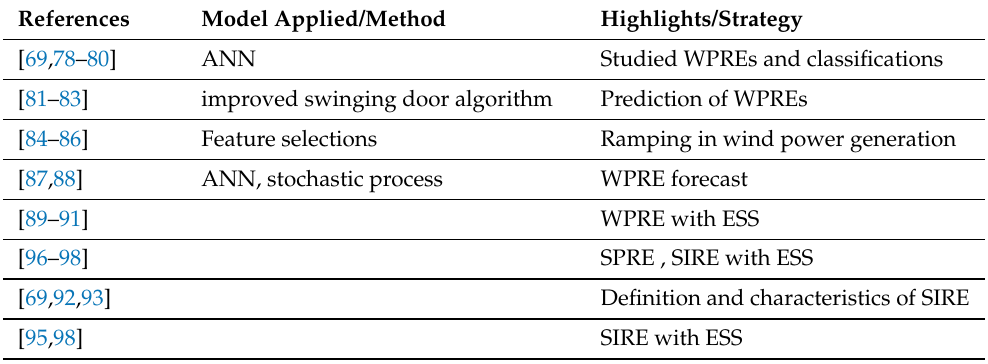
Table 1. Highlights of articles that discussed the characteristics of ramping events from wind and solar